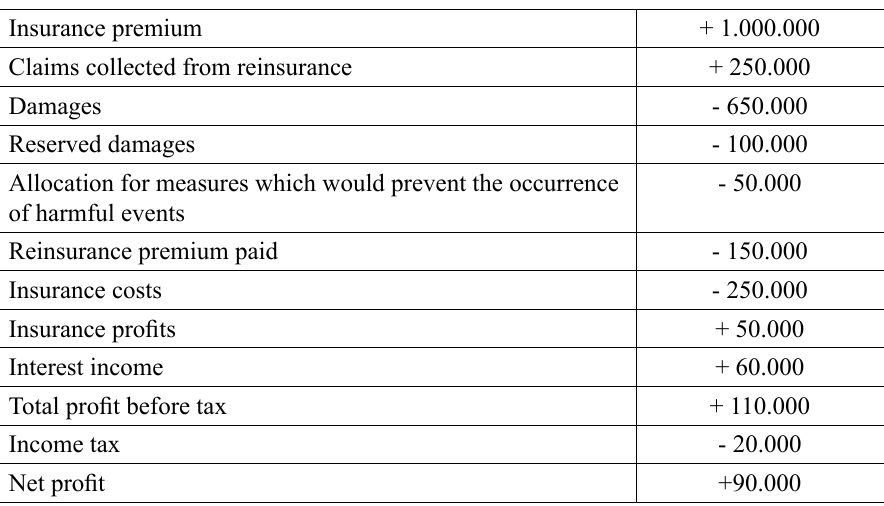
Table 2. Simplified layout of the income statement with insurers (for the period 1 st January – 31 st December of second- year) RSD